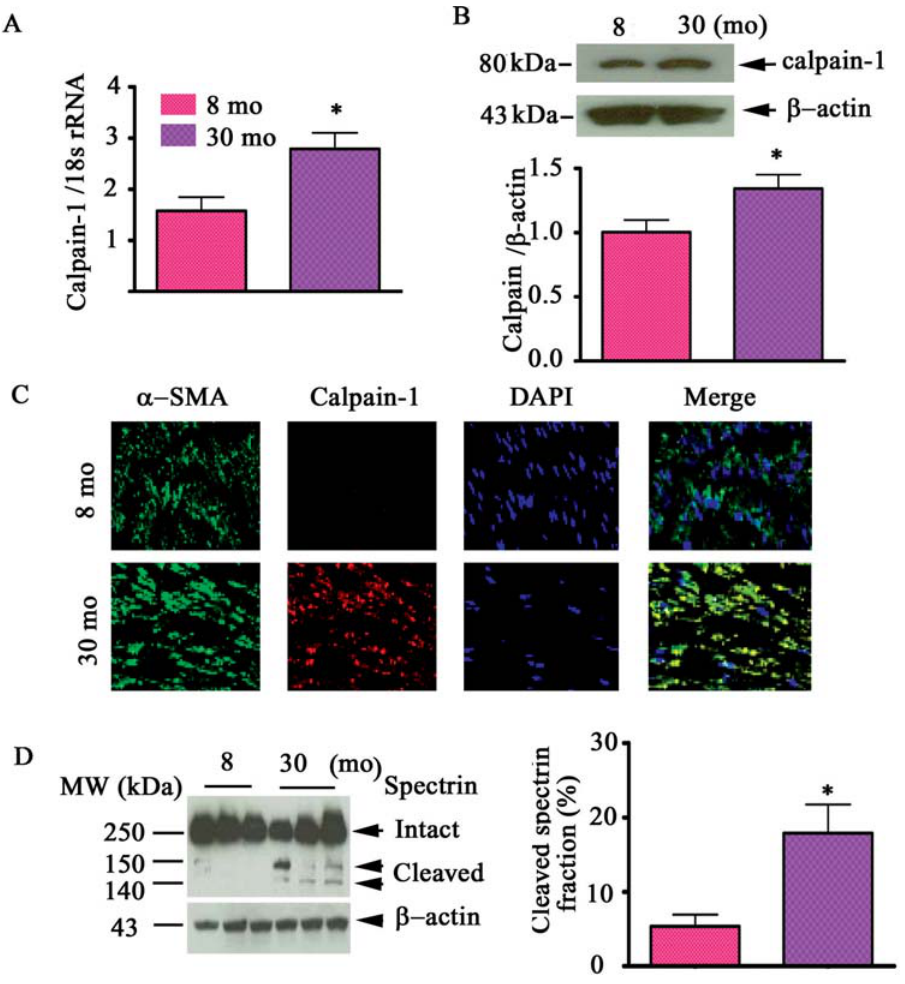
Figure 1. Calpain-1 transcriptome, protein abundance, and activity increase in the aged aortic wall. A. Average data of calpain-1 transcriptome. B. Western blots for calpain-1 protein of rat intact aortae (upper panel); average data (lower panel). C. Dual en face fluorescence staining for a -SMA (green), calpain-1 (red) in the medial aortic sections from young (upper panels) and old rats (lower panels). Nuclei were counterstained with DAPI (blue). Merged image is depicted in right panel (yellow-blue). Magnification: 6 400. D. Western blots for calpain substrate a - II spectrin from aortic lysates (left panels). Average cleaved spectrin fraction (right panel). *p , 0.05, old vs. young.